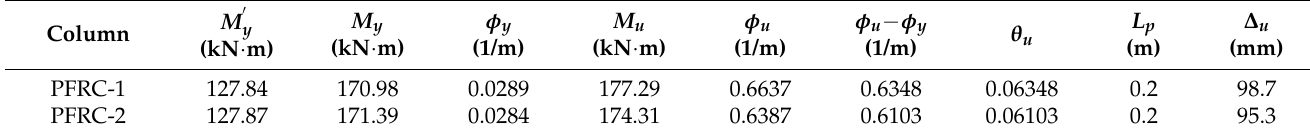
Table 5. Displacement-based seismic design